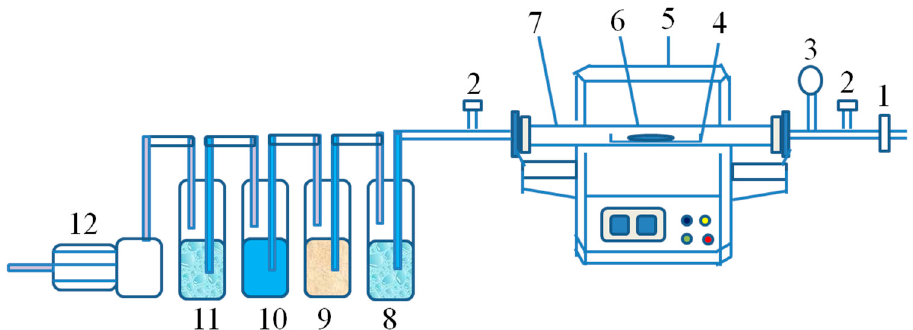
Figure 3. Conventional roasting device (1 = intake valve; 2 = flow meter; 3 = pressure gauge; 4 = crucible; 5 = furnace; 6 = sample; 7 = quartz tube; 8 = water; 9 = ammonia solution; 10 = dilute NaOH solution; 11 = water; 12 = small vacuum pump).